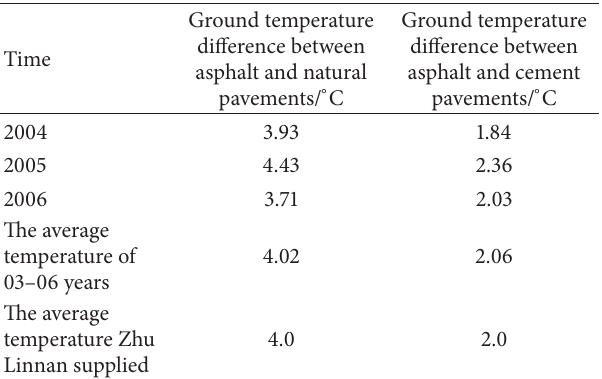
Table 1: The ground temperatures difference under asphalt pave- ment and cement pavement (the depth of 0.5